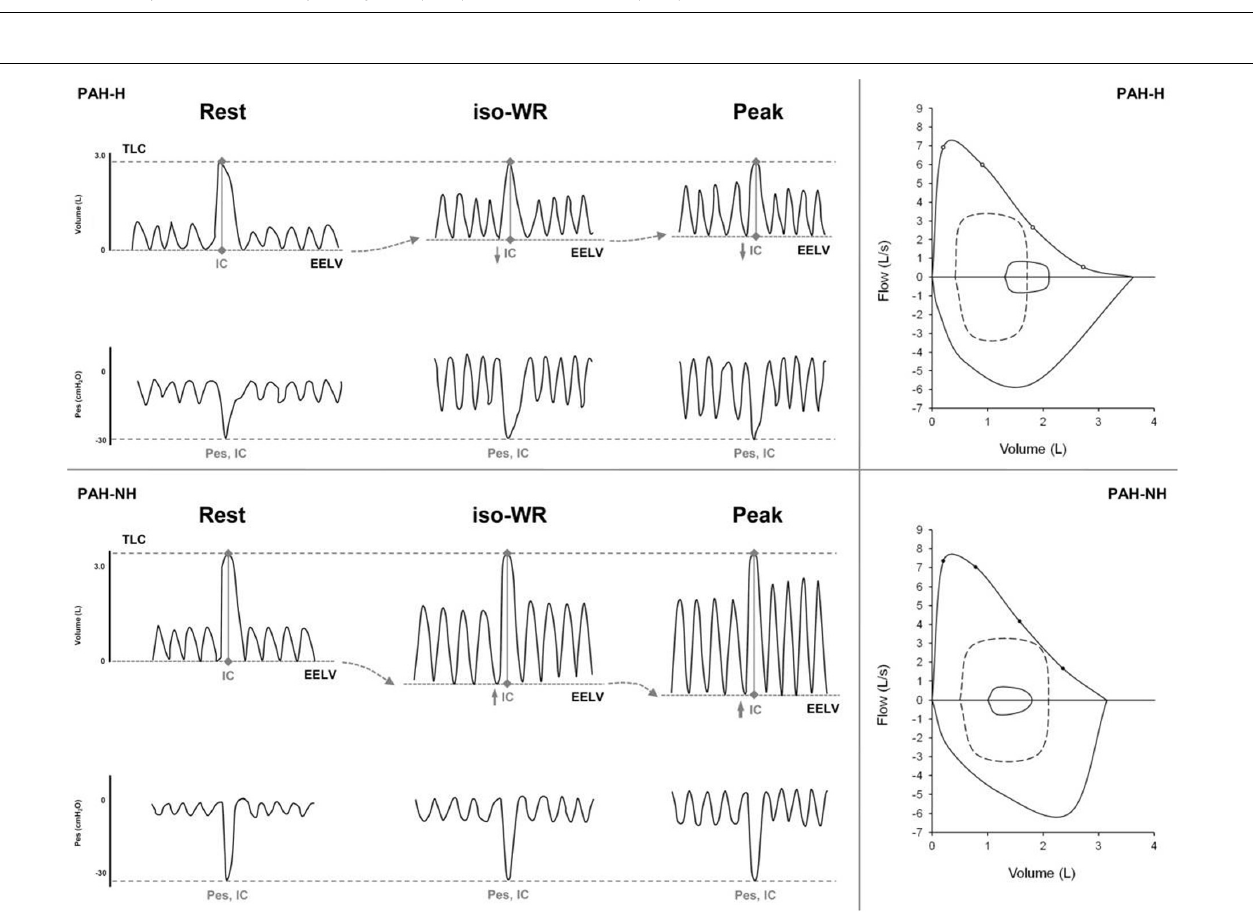
FIGURE 5 | Tracings of lung volume (Volume) and esophageal pressure (Poes) from inspiratory capacity (IC) maneuvers taken during resting breathing, at 60 watts (iso-WR) and peak-exercise from one representative PAH patient who reduced IC (or increased end- expiratory lung volume, i.e., EELV) during exercise [PAH hyperinflator (PAH-H), upper left panel] and one who increased IC (or reduced EELV) [PAH non-hyperinflator (PAH-NH), lower left panel]. Please note that, regardless of changes in IC during exercise, dynamic peak inspiratory Poes recorded during IC maneuvers (Poes, IC) is remarkably preserved in both PAH-H (upper left panel) and PAH-NH (lower left panel). Maximal and tidal flow-volume loops (average data) are shown at rest and at peak- exercise in PAH-H (upper right panel) and PAH-NH (lower right panel). Tidal flow-volume loops are provided at rest (solid line) and at peak-exercise (dashed line). Note a significant decrease in dynamic IC during exercise in PAH-H compared with PAH-NH. TLC, total lung capacity. Reproduced with permission of Laveneziana et al. (2015).